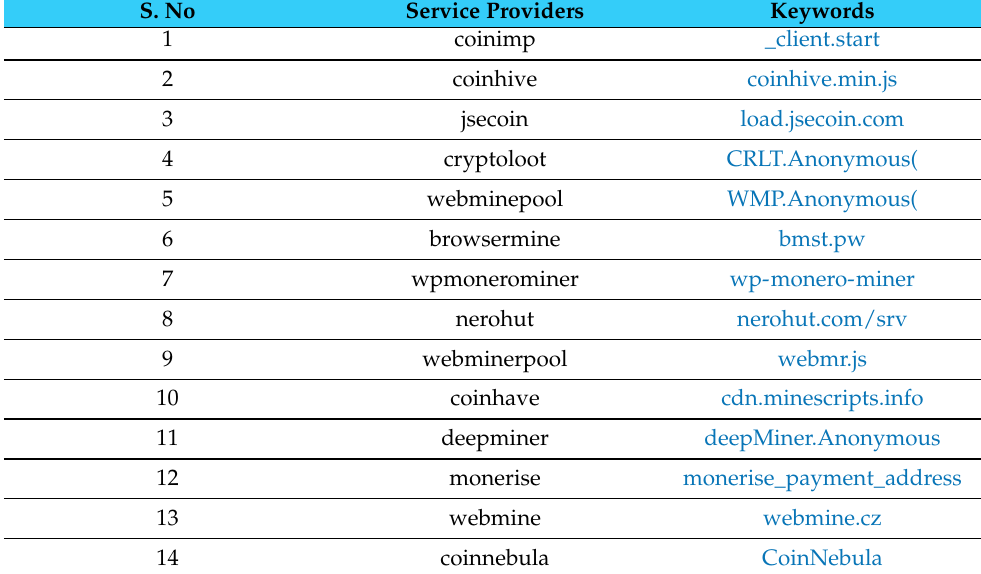
Table 3. Unique Public Service